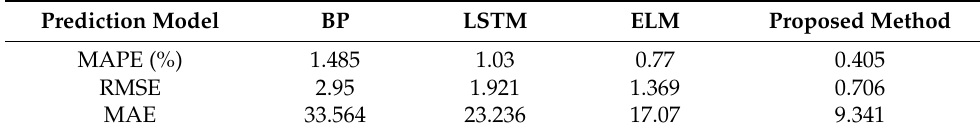
Figure 7. Load power of different forecasting methods. Table 3. Error comparison of different prediction